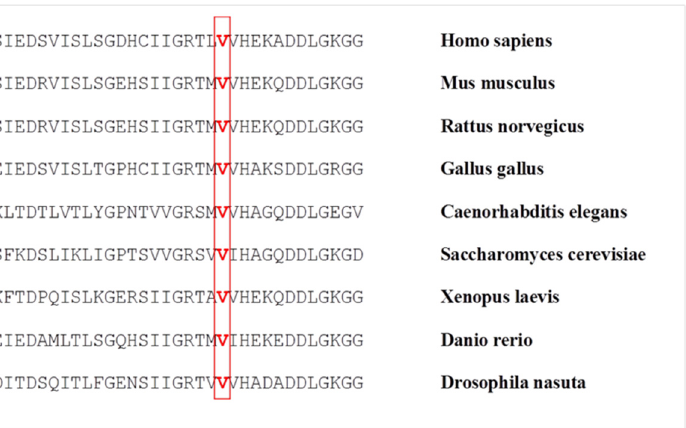
Figure 2. Protein alignment of the residues conserved across different species in SOD1 protein in the region around valine 119 (indicated in red).